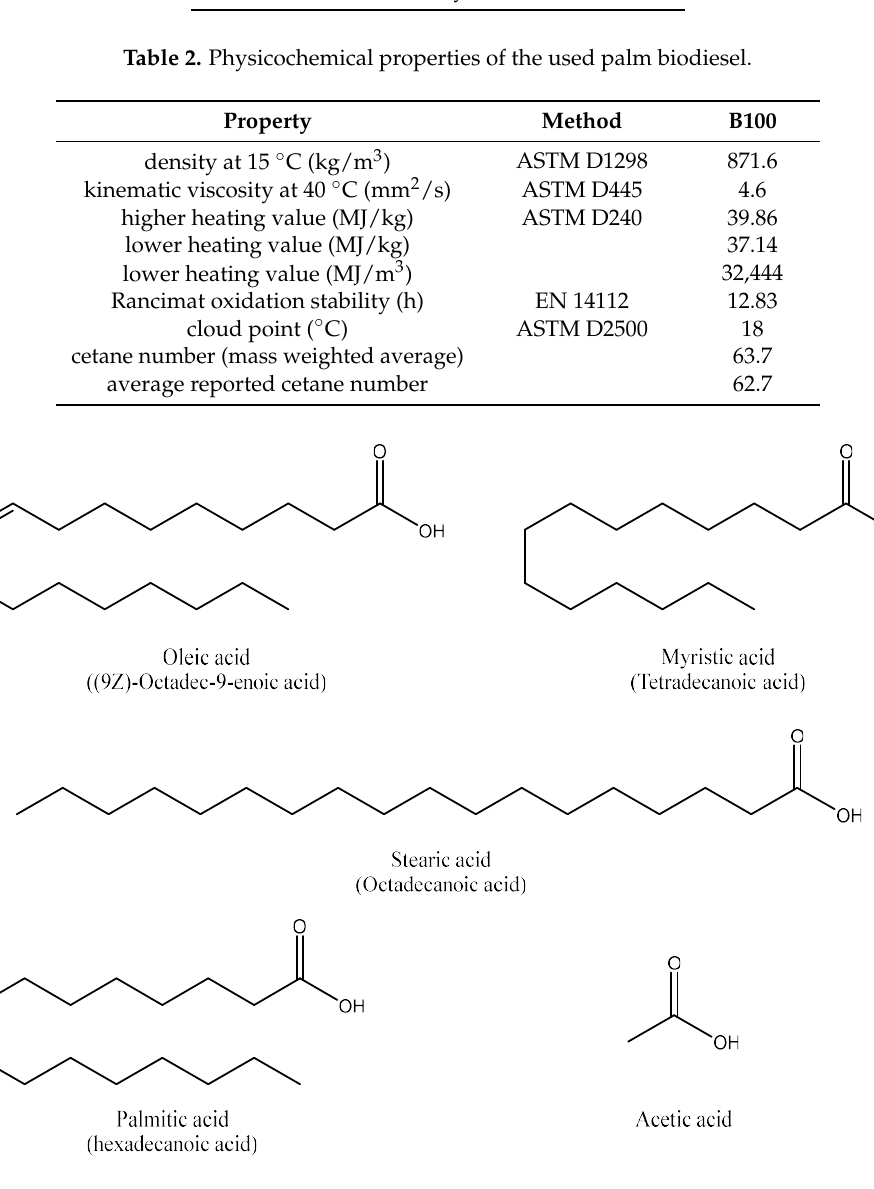
Figure 1. Chemical structures of the acids added to the biodiesel.